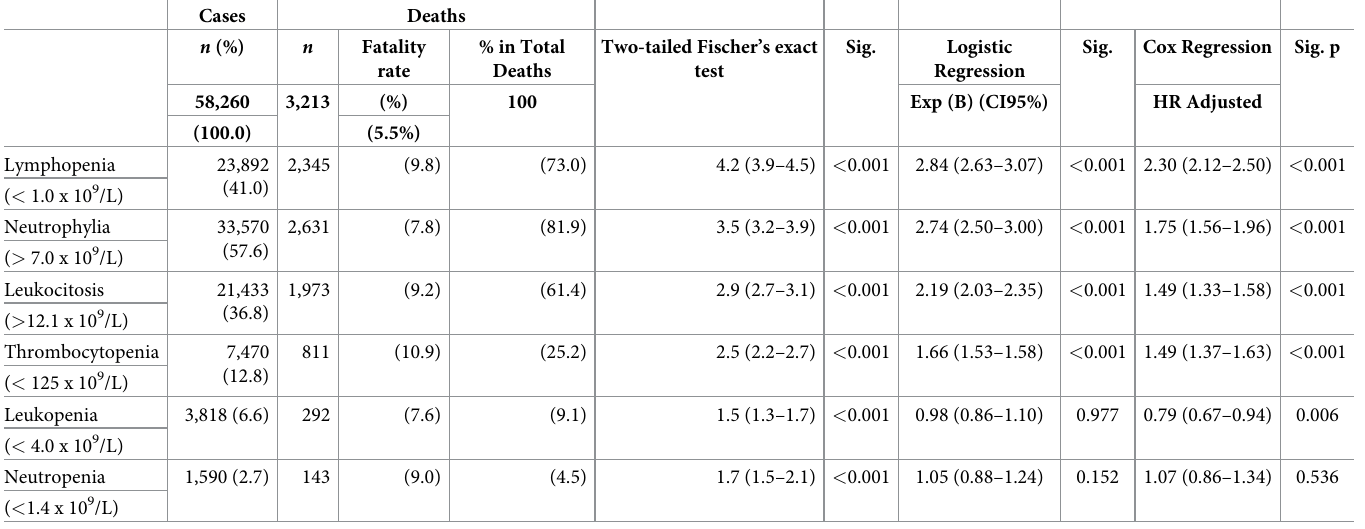
Table 3. Relationship between leukocyte and platelet counts with mortality